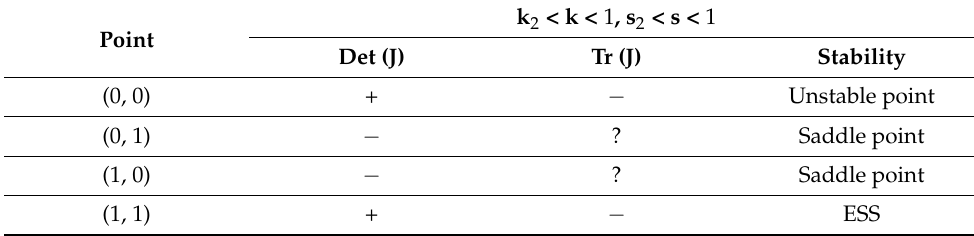
Table 19. Stability analysis of the points in case